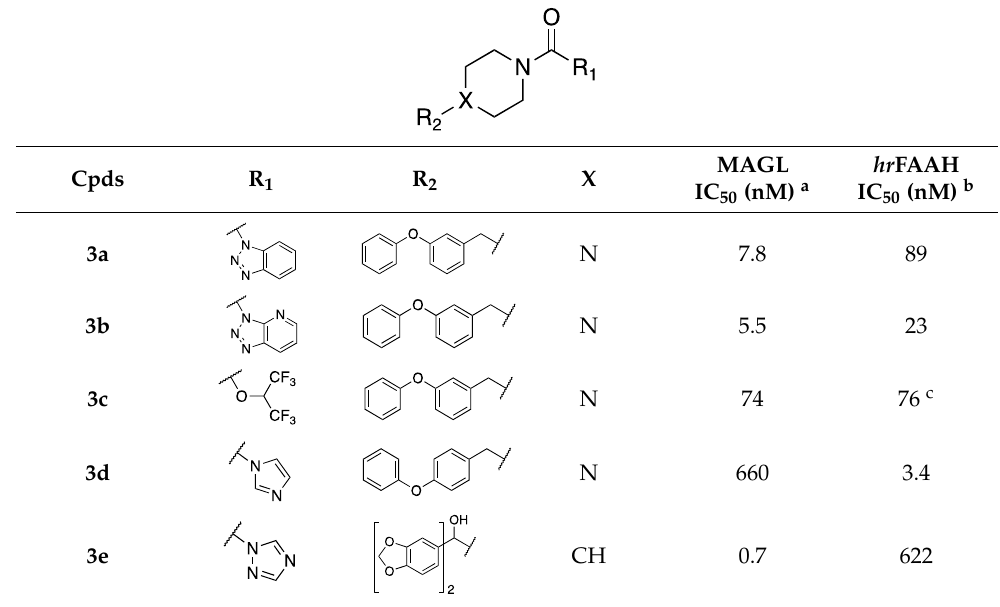
Table 2. IC 50 values on FAAH and MAGL enzyme for phenoxyphenyl piperazinyl and methylene-3,4-dioxyphenyl piperidinyl derivatives.